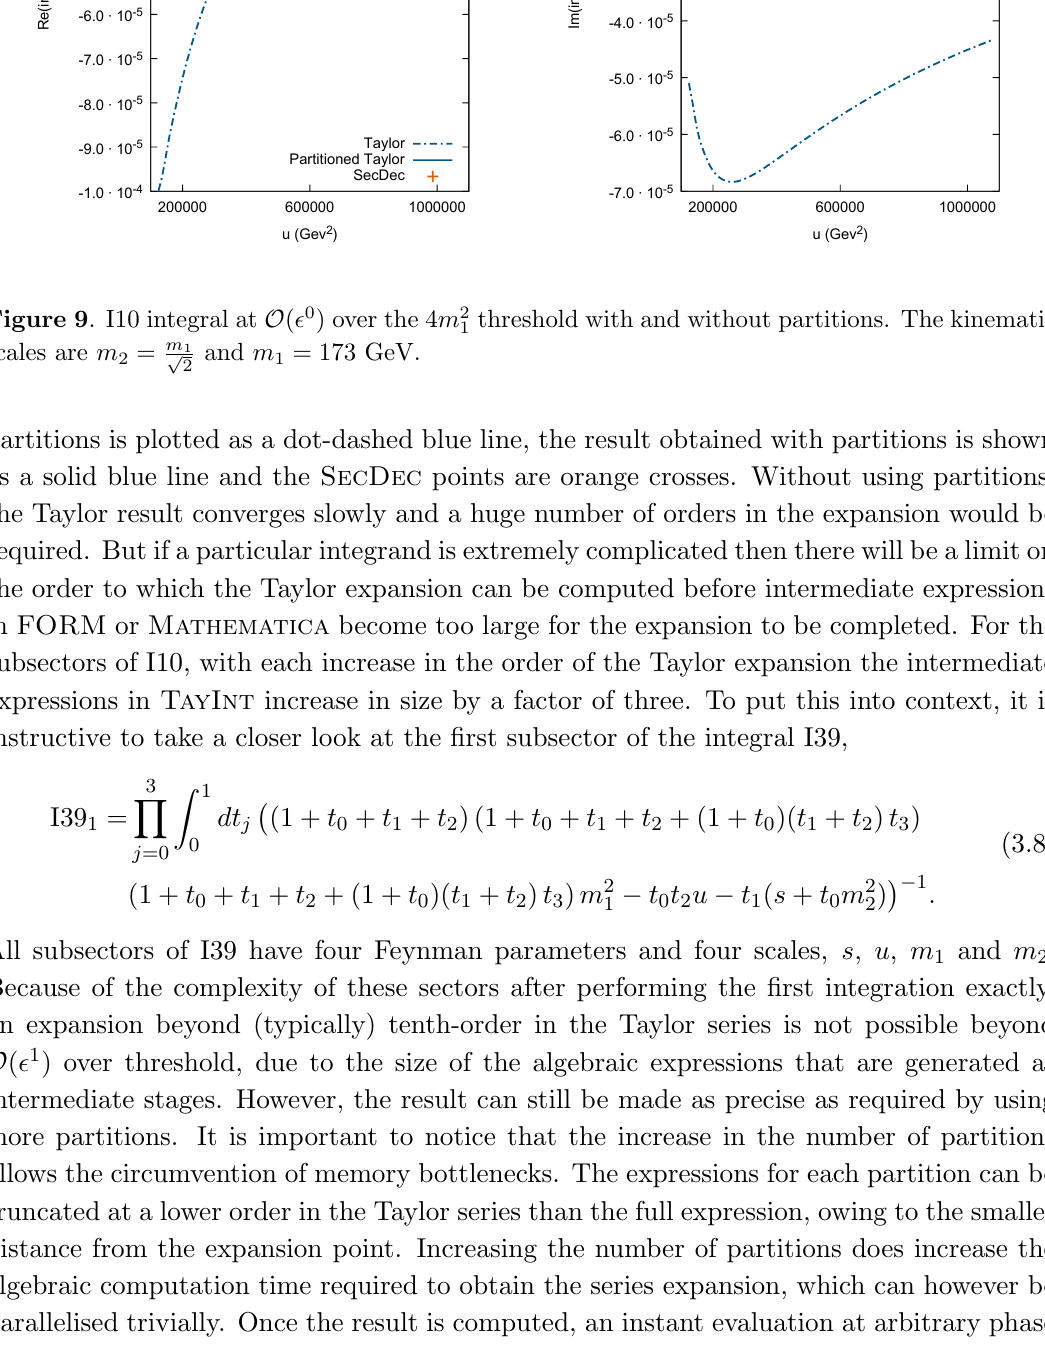
threshold with and without partitions. The kinematic 1